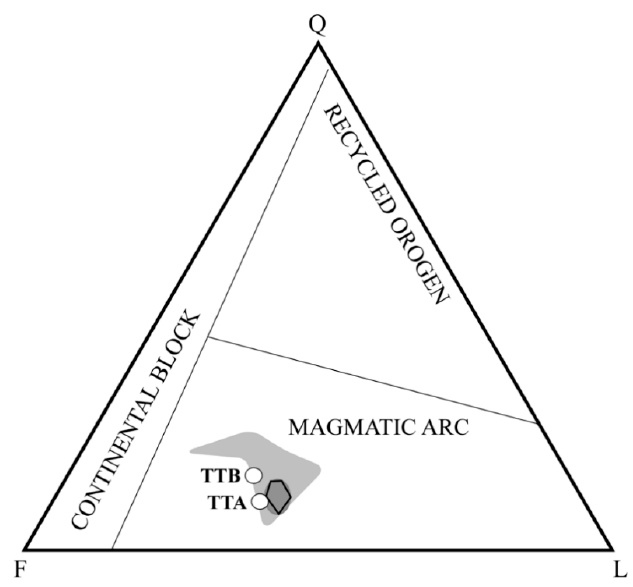
Figure 5. QFL triangular diagram with provenance indications [41,55,56]. The detrital mode of study samples TTA and TTB is compared to the literature data: light grey area [37,38]; black polygon [28]; dark grey oval [31]. Q, (total quartz); F, (feldspars); L, (fine-grained lithic fragments).